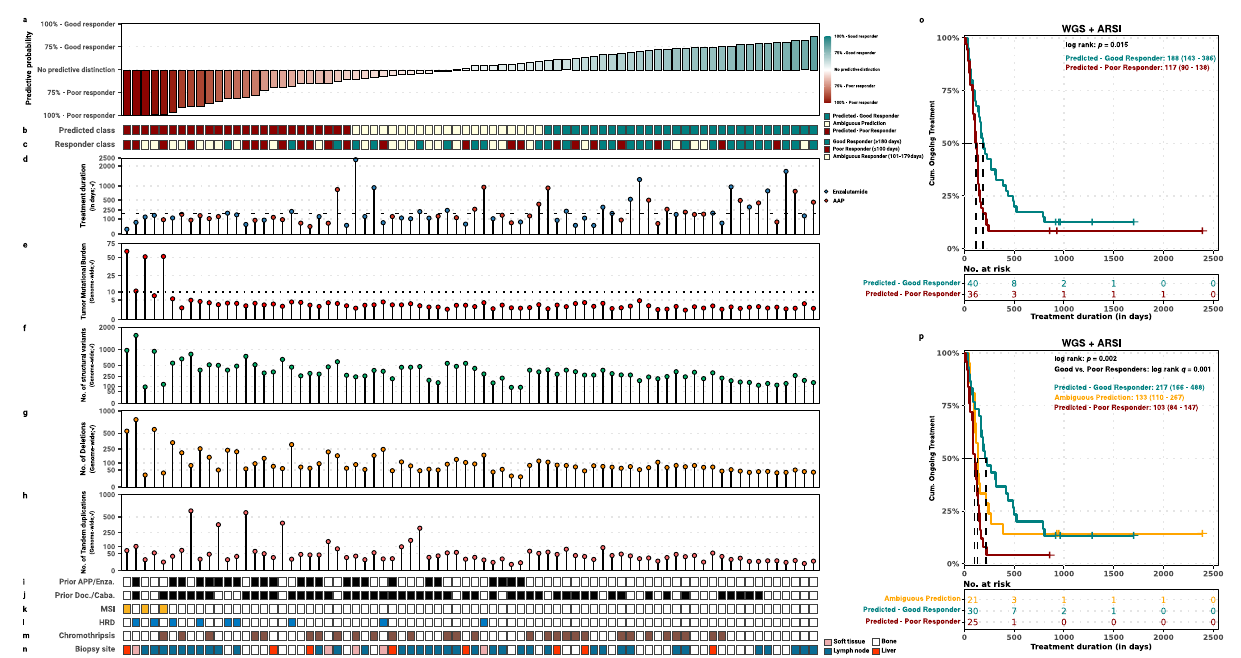
Fig. 6 | Overview of the clinicogenomics prediction model on the internal validationcohorta-n). Overviewofthepredictionscoresandgenomicfeaturesfor classifying as a poor or good responder within the internal validation cohort ( n =76) using the clinicogenomic classi fi cation model. Samples are ordered by descending prediction score (poor to good responder). A prediction score of at least 60% for one of two respective classes (poor or good responder) were required, otherwise samples were designated as ambiguous predictors. For each patient ( n =76), the following tracks are shown: a Prediction score. The prediction score for either the good or poor responder class. A score of 0.5 means equal likelihood of being either class. b Predicted class based on the clinicogenomics classi fi er. c True responder class, based on ARSI treatment duration. d Type and duration of ARSI treatment. Y-axis representing the ARSI treatment duration (in days) whilst the coloring represents the type of given treatment (abiraterone acetate + prednisone in blue, enzalutamide in orange). Y-axis is shown in square- root transformed scale. e Tumor mutational burden (TMB). The number of